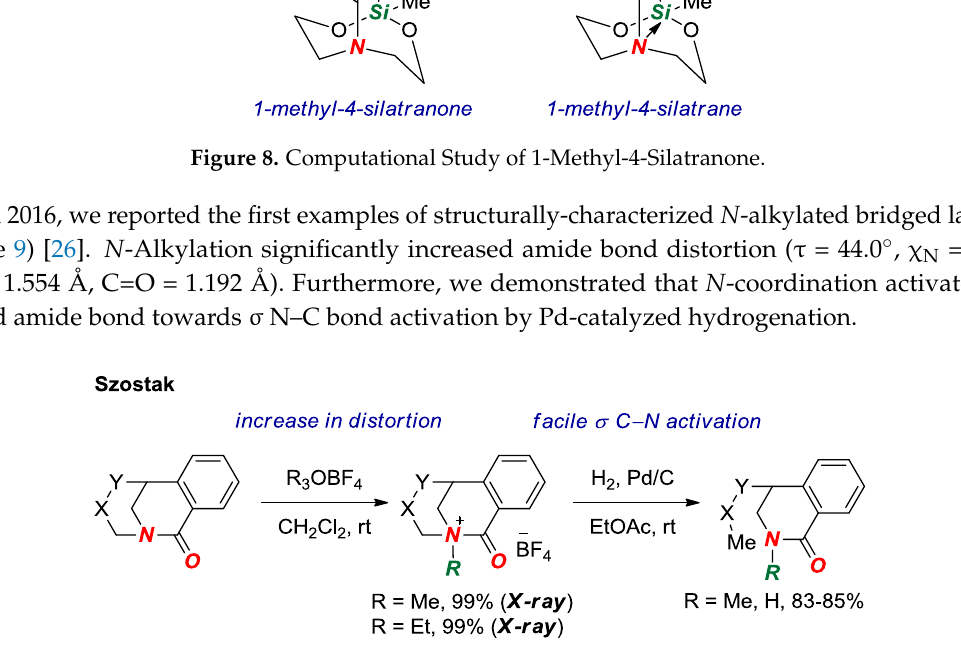
Figure 9. N -Alkylation of Bridged Lactams as a Trigger for σ N-C Bond Activation.